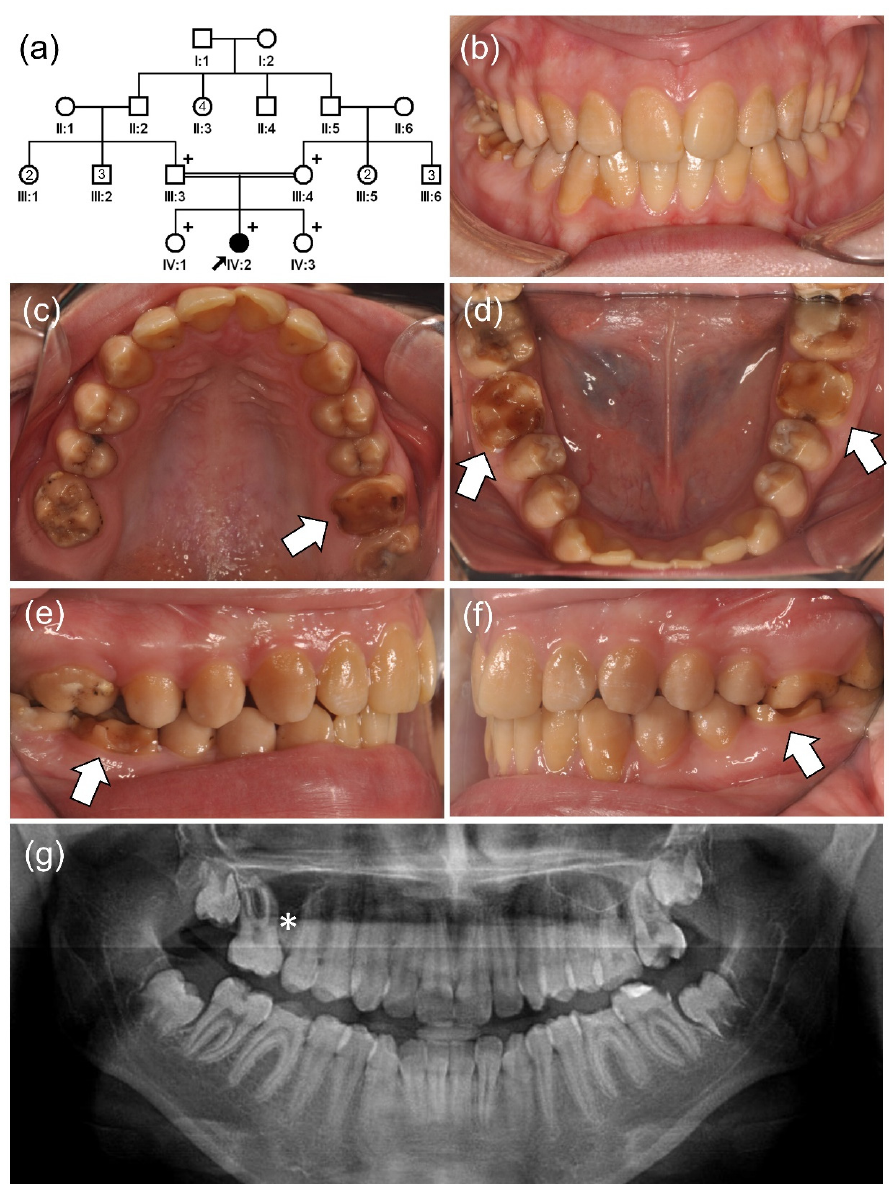
Figure 2. ( a ) Pedigree of family 4. The black arrow denotes the proband. Plus (+) symbols indicate participating individuals in this study. Number in the symbol indicates the number of siblings. Consanguineous marriage is shown by a double line. ( b – f ) Clinical photos of the proband (IV:2). Hypomatured enamel exhibits a generalized yellow-brown discoloration. Early loss of weak enamel can be seen in the permanent first molars. ( g ) Panoramic radiograph shows hypomineralized enamel with reduced radiodensity. The maxillary right first molar (*) was extracted due to severe